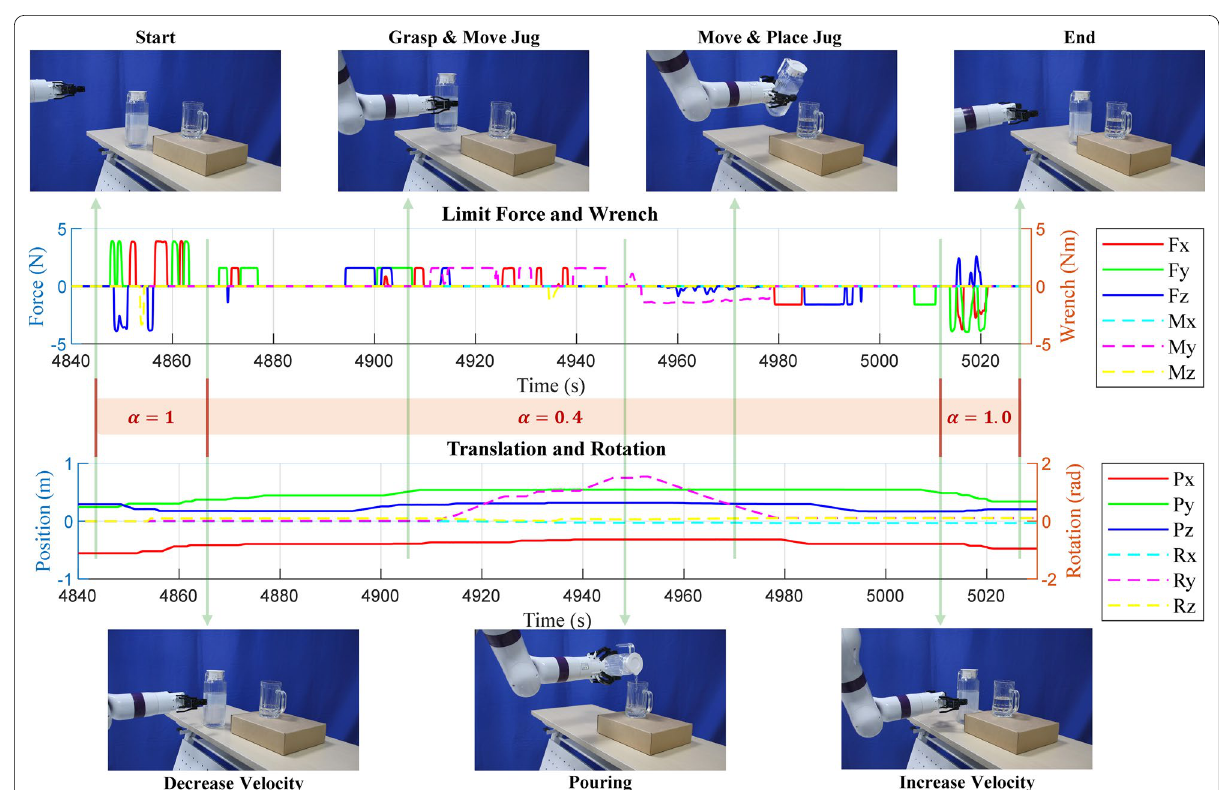
Figure 10 Results of the third experiment that THCobot was teleoperated to grasp a jug and pour water into a